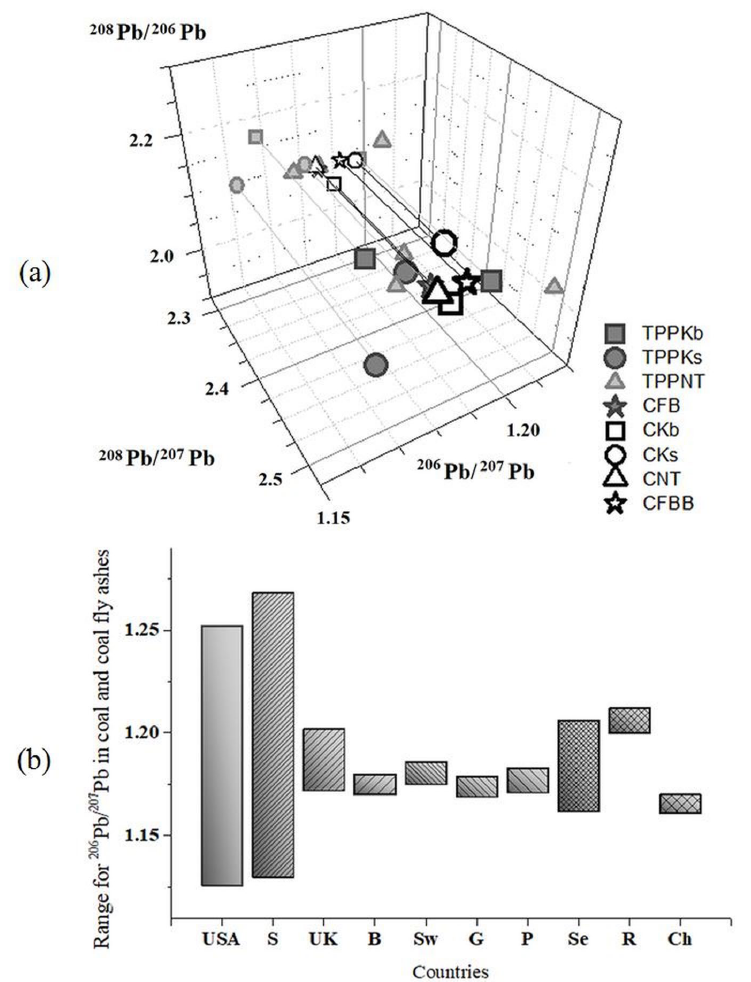
Figure 5. ( a ) Three-dimensional diagram of Pb isotope ratios in fly ashes (TPPKb, TPPKs, TPPNT, and CFB) and correspondent coals (CKb, CKs, CNT , and CFBB); ( b ) range for 206 Pb/ 207 Pb in different countries worldwide from west to east , i.e., USA : United States of America ; S : Spain ; UK: United Kingdom; B : Belgium ; Sw : Switzerland ; G : Germany ; P : Poland ; Se : Serbia ; R : Russia ; and Ch: China.